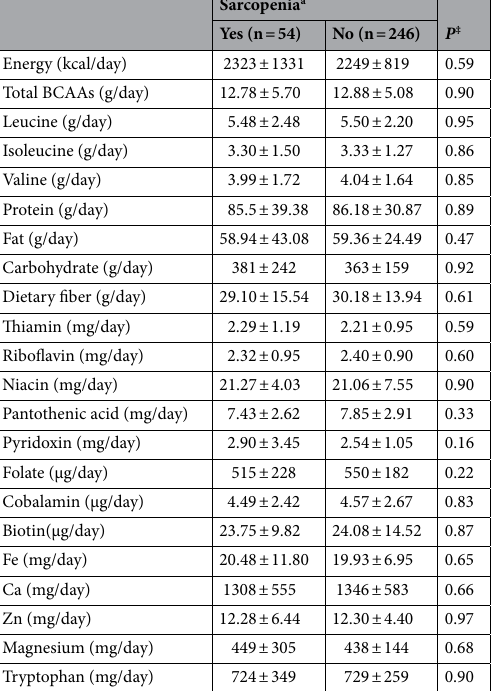
Table 2. Comparison of dietary intakes of participants with and without sarcopenia. All values are mean ± SD; energy intake is adjusted for age and sex, all other values are adjusted for age, sex and energy intake. a Sarcopenia was defined based on European Working Group on Sarcopenia in Older People (EWGSOP) definition 27 . ‡ ANOVA for all variables. BCAAs branched-chain amino acids.